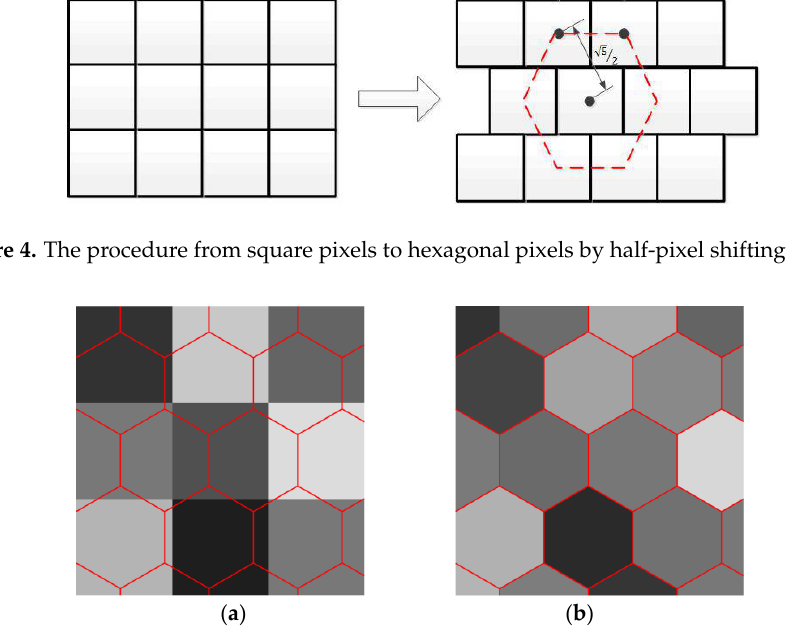
Figure 5. Illustration of the square to hexagonal lattice conversion by the hyperpel method ( a ) the sub-pixels in each surrounded area by red boundary are clustered together for the corresponding hexagonal pixel and ( b ) the value of each hexagonal pixel is the average intensity of the sub-pixels within each cluster [35].